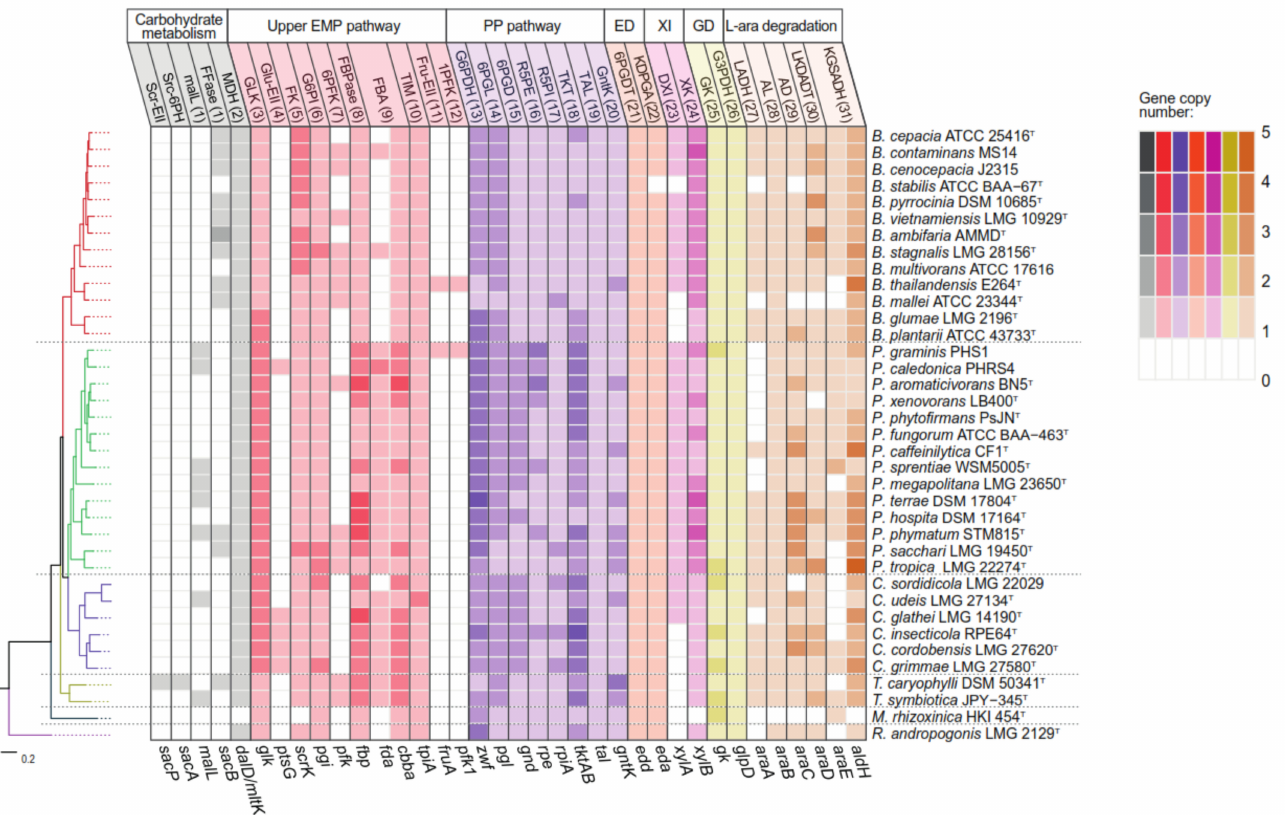
Figure 4. Genomic comparison of the metabolism for the conversion of sugars and glycerol into PHA by Burkholderia sensu lato (s.l.) strains. Enzymes functions and their respective coding genes are listed above and below the graph, respectively. Numbers shown in parenthesis following the enzyme activity correspond to reactions represented in Figure 2. Color intensity depicts the gene copy number as showed in legend. Homology prediction of 27 strains was performed using the curated metabolic networks of the Kyoto Enzyme and Genomes Database (KEGG) and manual Blast search through Bidirectional Best Hit approach (BBH). For the 10 strains belonging to novel genera (e.g., Caballeronia , Trinickia , Mycetohabitans , Robbsia ) a manual reconstruction through BBH was performed. An amino acid sequence identity of >30% and ≥ 70% coverage was used as threshold in function of the gene context for homology prediction. Genomes were retrieved from Refseq database. Strains are arranged according to a phylogenomic tree constructed from a concatenate of 38 core genes present in the 37 genomes using Phylophlan and MAD root softwares. Scr-EII, sucrose transporter of the phosphoenolpyruvate system (PTS) family; Scr-6PH, sucrose-6-phosphate hydrolase; MalL, α -glucosidase; FFase, β -fructofuranidase,